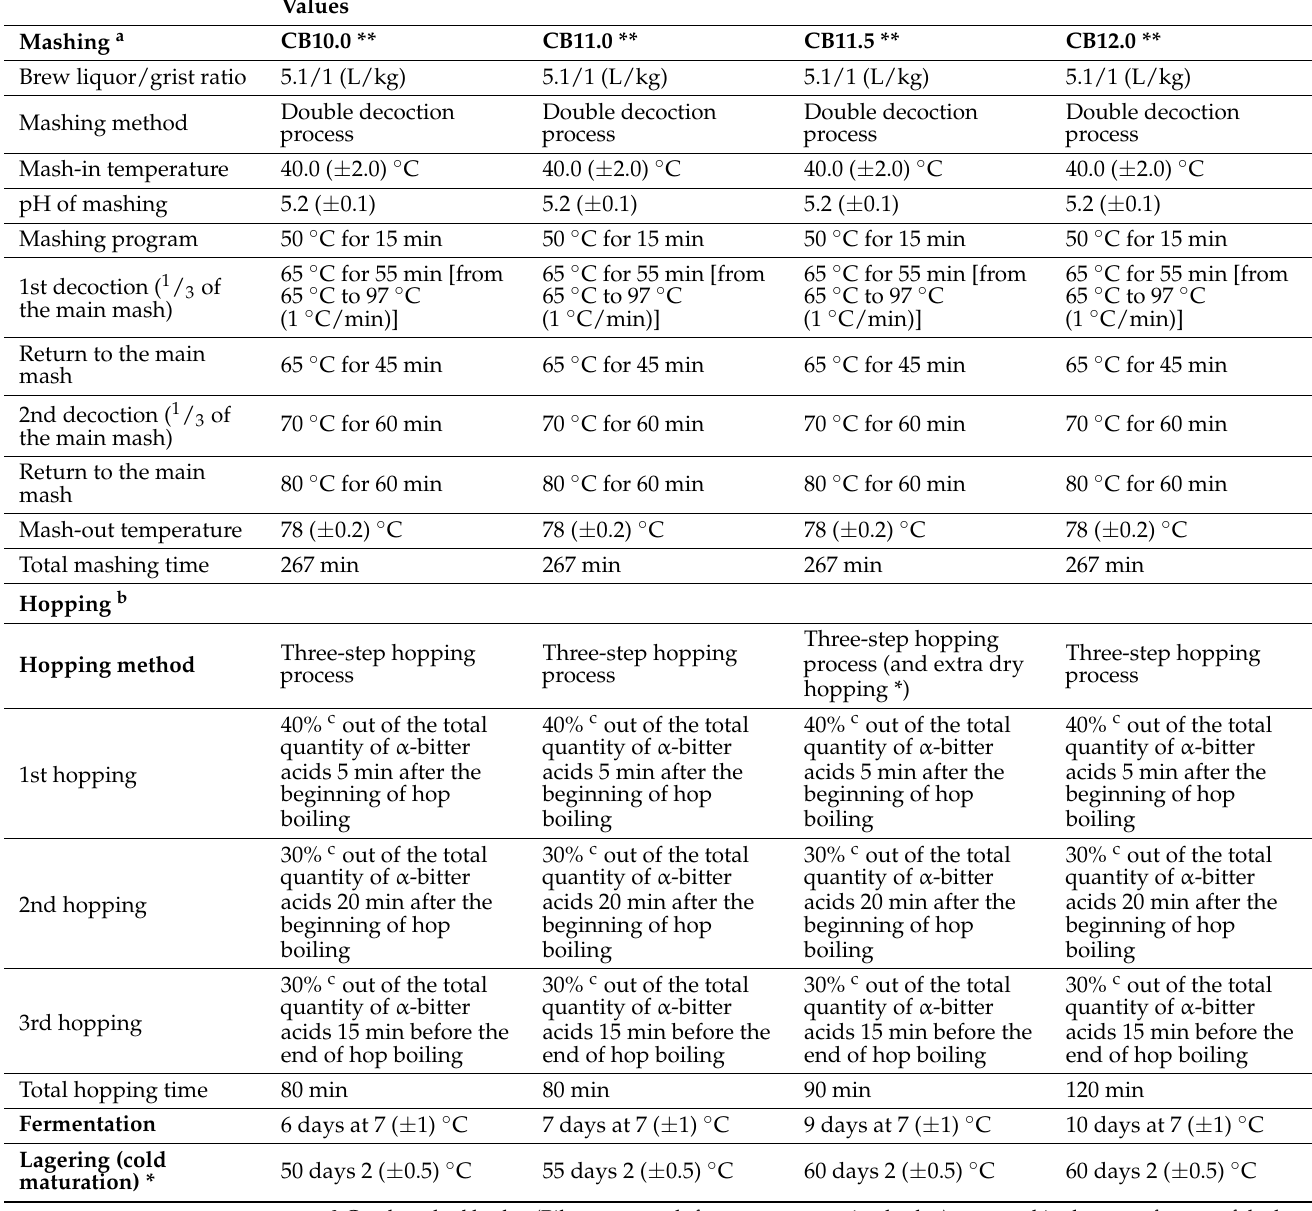
Table 1. Brewing